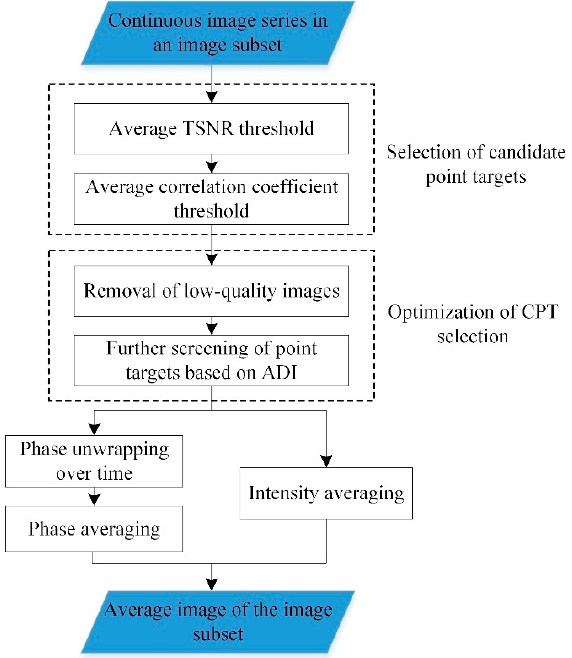
Figure 2. Processing of a continuous image series in an image subset and calculation of the average image of the image subset. Abbreviations: TSNR, thermal signal-to-noise ratio; ADI, amplitude deviation index; CPT, coherent point targets.